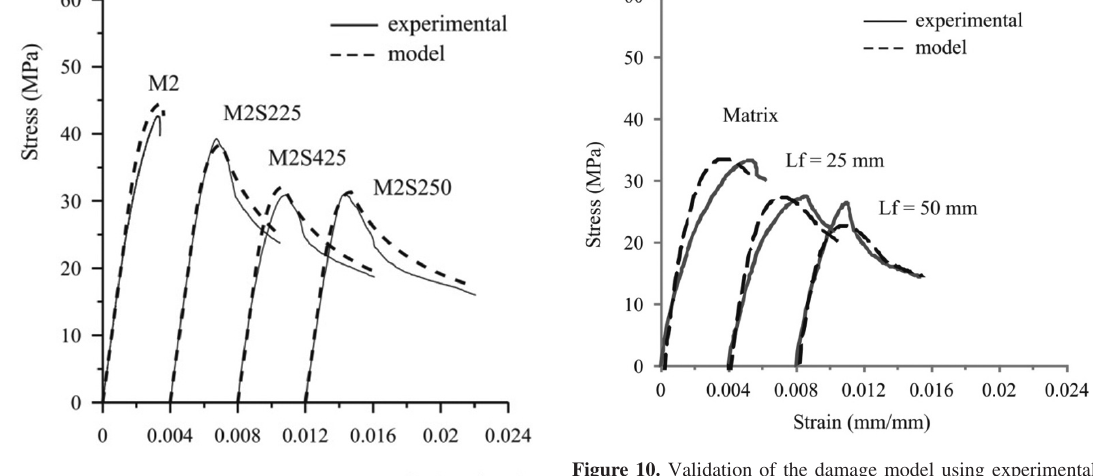
Figure 10. Validation of the damage model using experimental results obtained by Ferreira 33